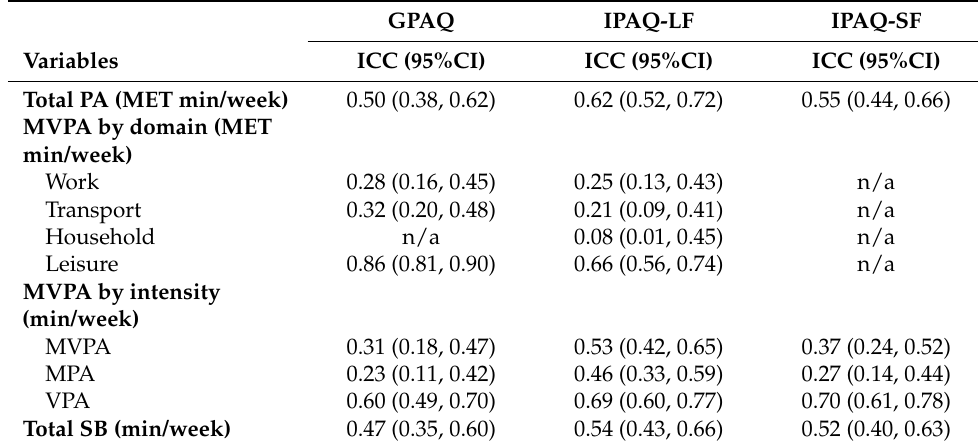
Table 3. Test–retest reliability of GPAQ, IPAQ-LF and IPAQ-SF ( n =